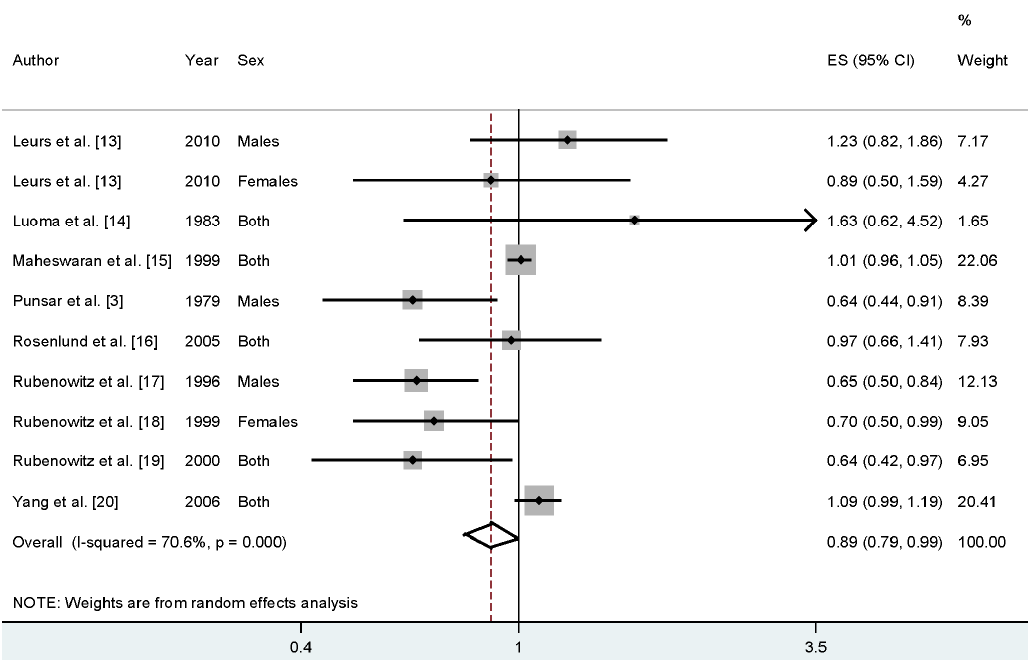
Figure 2. The forest plot between the levels of magnesium in drinking water and CHD mortality risk.